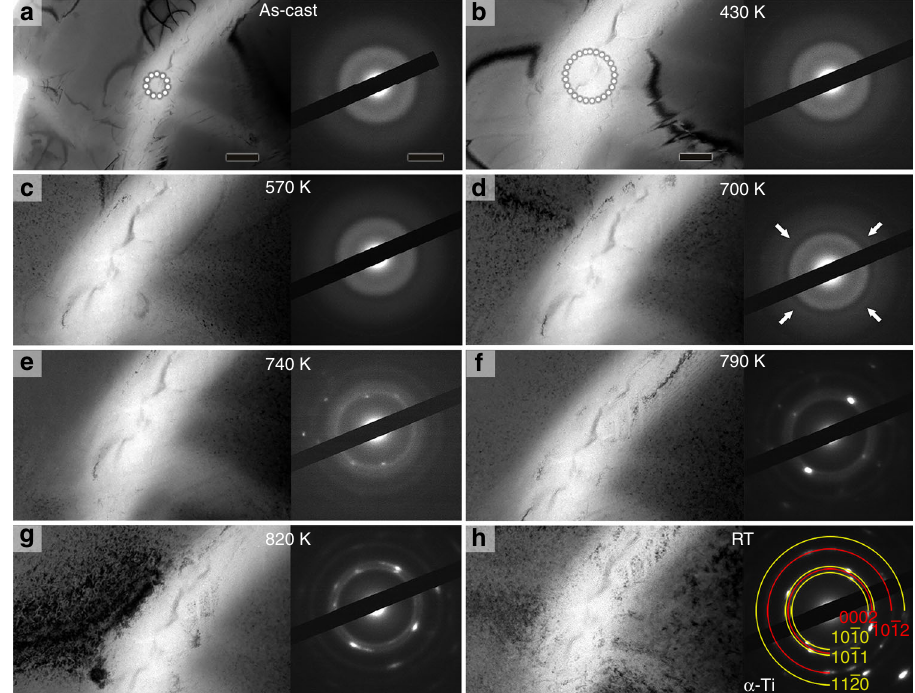
Fig. 3 Microstructure and SAED patterns of Ti 59.1 Zr 37 Cu 2.3 Fe 1.6 rod with a diameter of 8 mm during in situ heating in the TEM. a As-cast state. b – g In situ heating to temperatures below the α → β transition temperature. The amorphous phase begins to transform to α -Ti at around T = 700 K. h After cooling to room temperature (RT), α -Ti, the equilibrium phase, is only observed. Scale bars in a represent 200 nm for the micrograph and 2 nm − 1 for the SAED pattern, respectively. Scale bar in b is 100 nm which also applies to c –